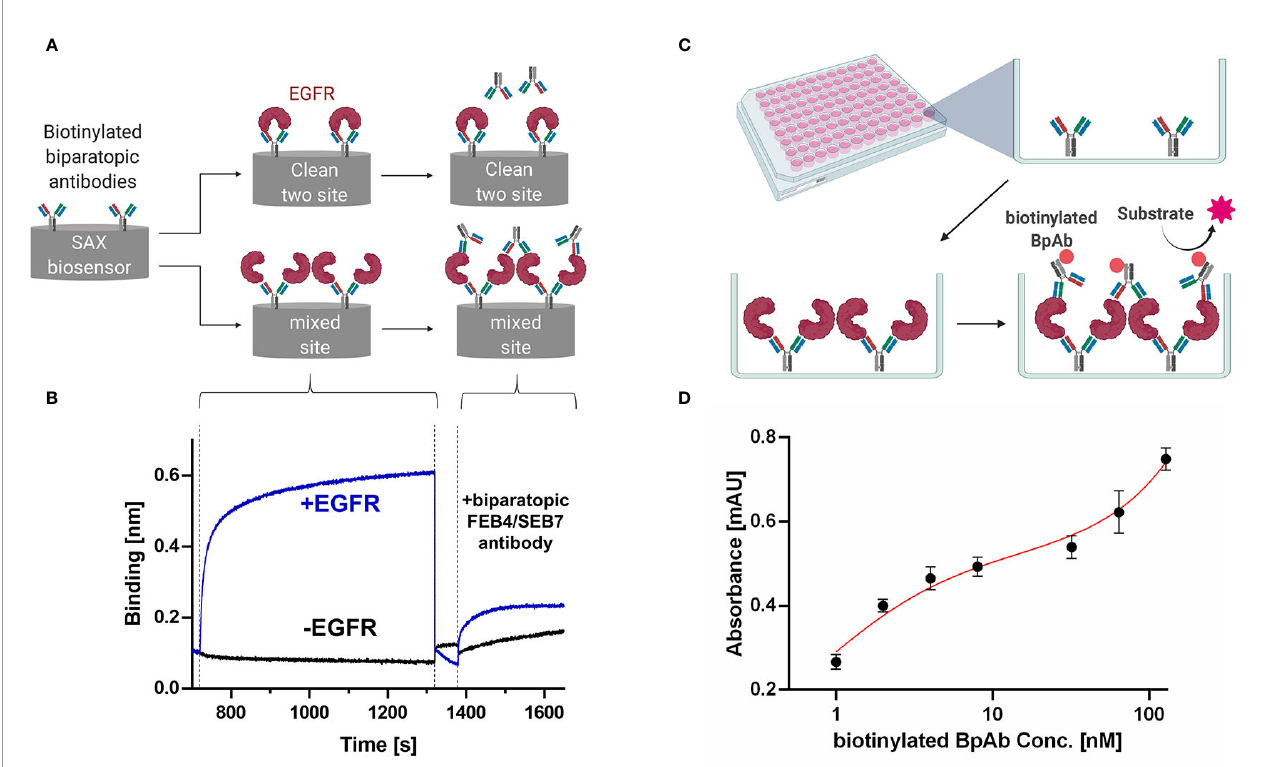
FIGURE 5 | Clustering assay of the biparatopic antibody. (A) Schematic representation of BLI-based two-site binding assay that can either result in a clean two-site binding or a mixed site binding. (B) BLI-based two-site binding assay. Biotinylated BpAb was loaded onto SAX tips followed by incubation with EGFR-ECD or kinetics buffer, respectively. Subsequently, binding of unmodi fi ed BpAb to the complex was analyzed. Each step was aligned separately (C) Schematic representation of ELISA-based two-site binding assay. (D) ELISA of BpAb binned against itself. 50 µl of a 25-nM BpAb solution was coated on a 96-well MaxiSorp MTP (ThermoFisher) overnight, followed by incubation with 200 nM EGFR-ECD and varying concentrations of biotinylated BpAb (1 – 128 nM). Binding was detected utilizing Streptavidin-HRP and TMB-One solution (Promega). Each concentration was measured in triplicates and analyzed using GraphPad Prism 8. A two-site speci fi c binding fi t was applied. Created with BioRender.com.